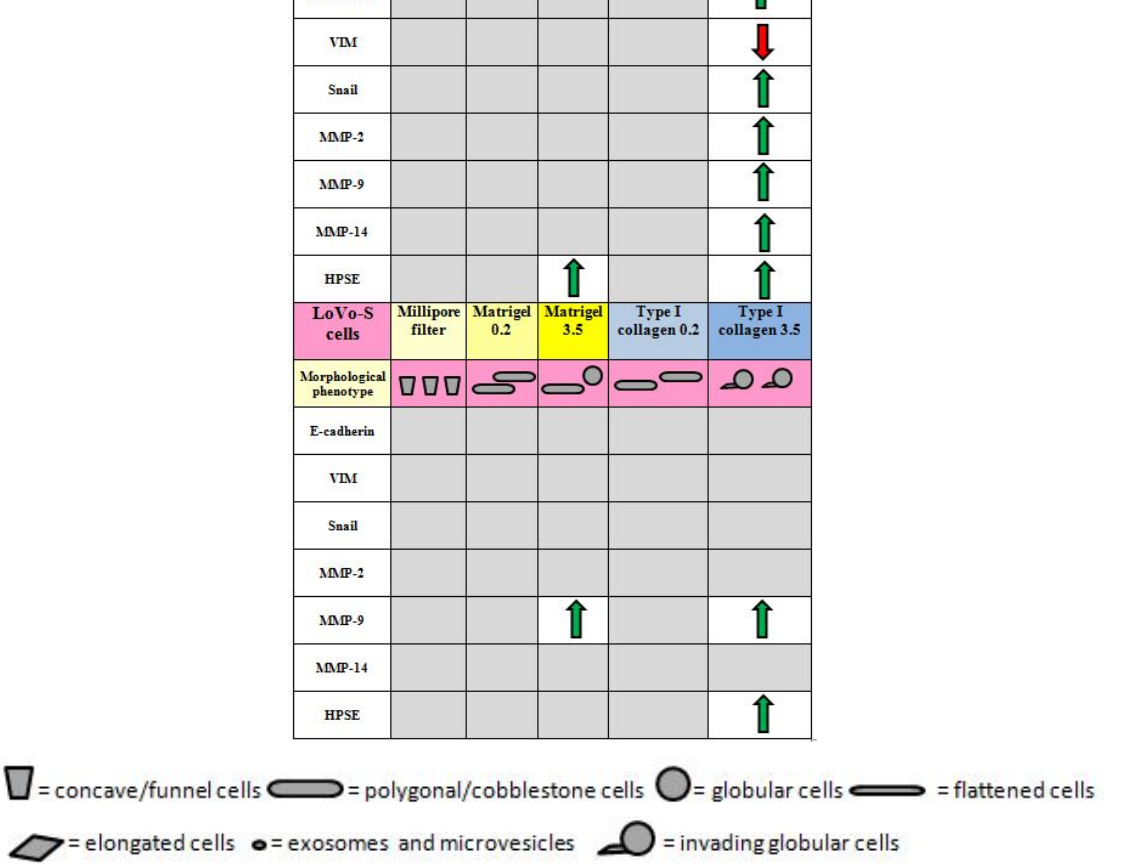
Figure 7. Effects of different substrates on gene expression and morphological phenotype in Lovo-S/-R cells. The green arrows show an increase in the EMT markers or matrix-degrading enzymes, whereas the red one means a decrease in the mesenchymal marker vimentin. Grey zones represent no-significant differences among the different substrates.